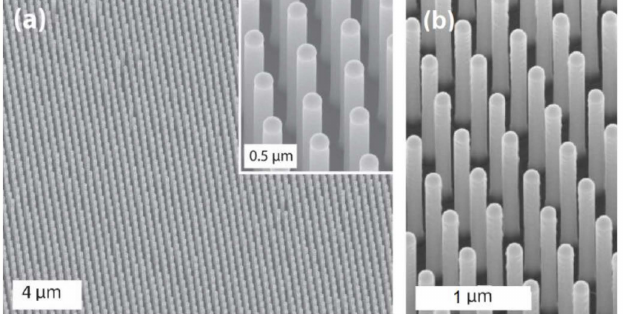
Figure 5. SEM tilted views of: ( a ) GaInP nanowire arrays with NW diameter D = 186, nm and pitch = 500 nm, grown by means of gold-catalyzed MOVPE on InP (111) substrates pre-patterned by using nanoimprint lithography (adapted with permission of Ref. [136], ( b ) InP NW array with period p = 400 nm, NWs diameter D = 138 ± 4 nm and length L = 1620 ± 40 nm; samples were grown on InP (111) B substrates previously pre-patterned by defining 160 nm diameter and 20 nm high Au catalyst particles in periodic arrays with a pitch of 400 nm using nanoimprint lithography. (Reprinted with permission of Ref.